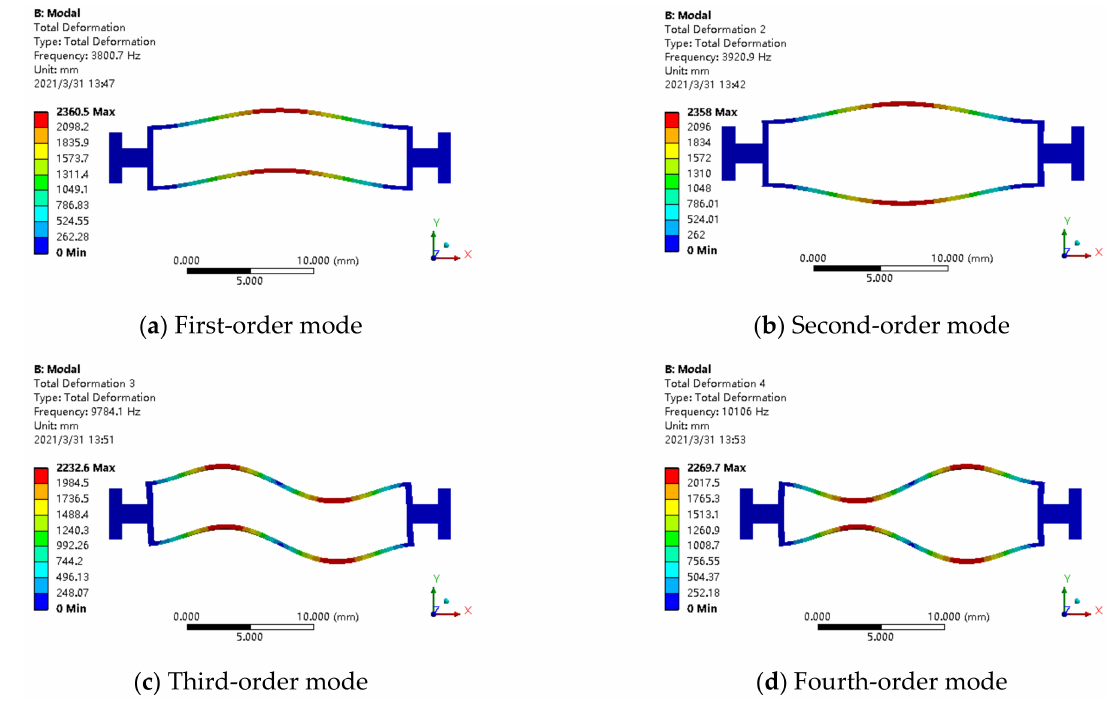
Figure 14. Beam root 3: ( a ) first-order mode; ( b ) second-order mode; ( c ) third-order mode; ( d ) fourth-order mode.